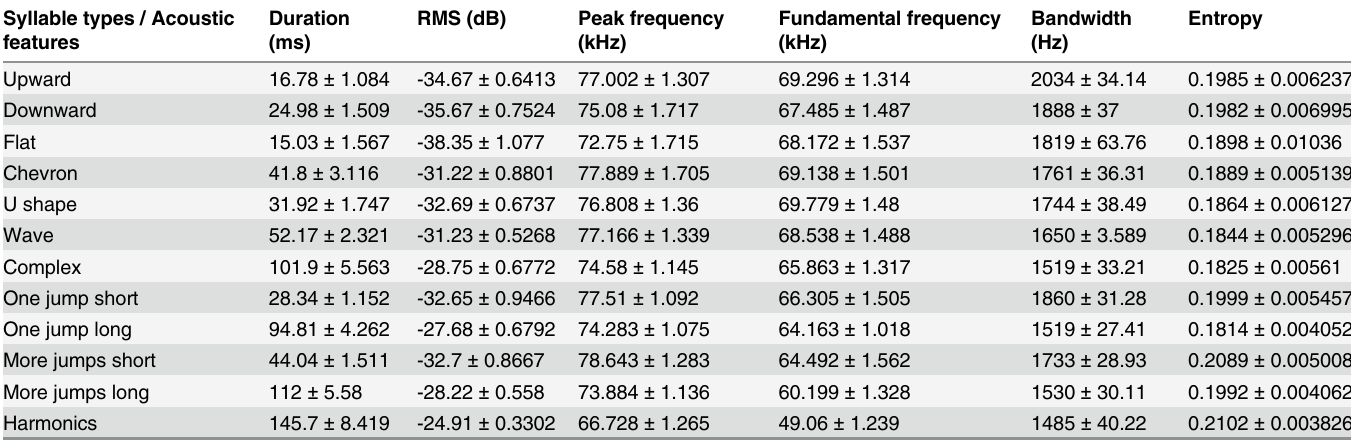
Table 1. Acoustic features of the 12 syllable